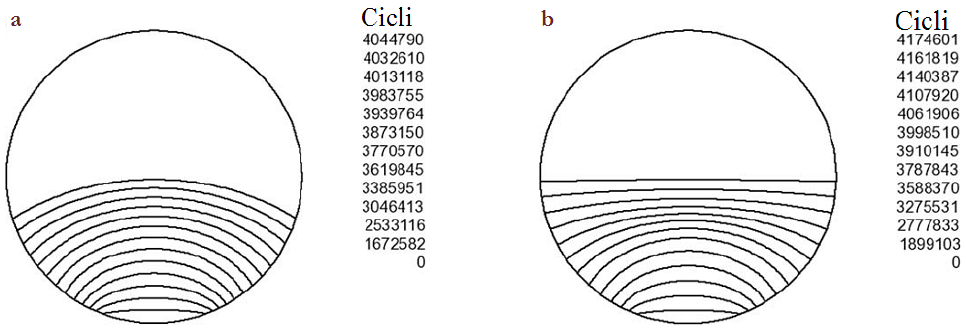
Figura 16: Forma calcolata del fronte di cricca in corrispondenza di numeri crescenti di cicli in una barra a sezione circolare, Figure 16: Calculated crack geometry at selected cycle numbers in a round bar, either with homogeneous tempered martensite microstructure (a) or exhibiting pearlite at core